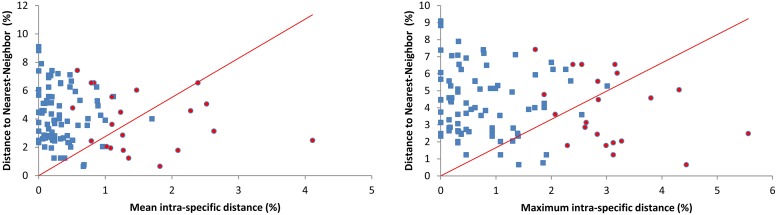
Mean intraspecific distance and maximum intraspecific distance (K2P) plotted against minimum distances to the nearest neighbor (NN) species for 103 species of Pyraustinae.Blue squares represent species assigned to a single BIN, while red circles are species placed in two or more BINs. Points above the diagonal line indicate species with a barcode gap.